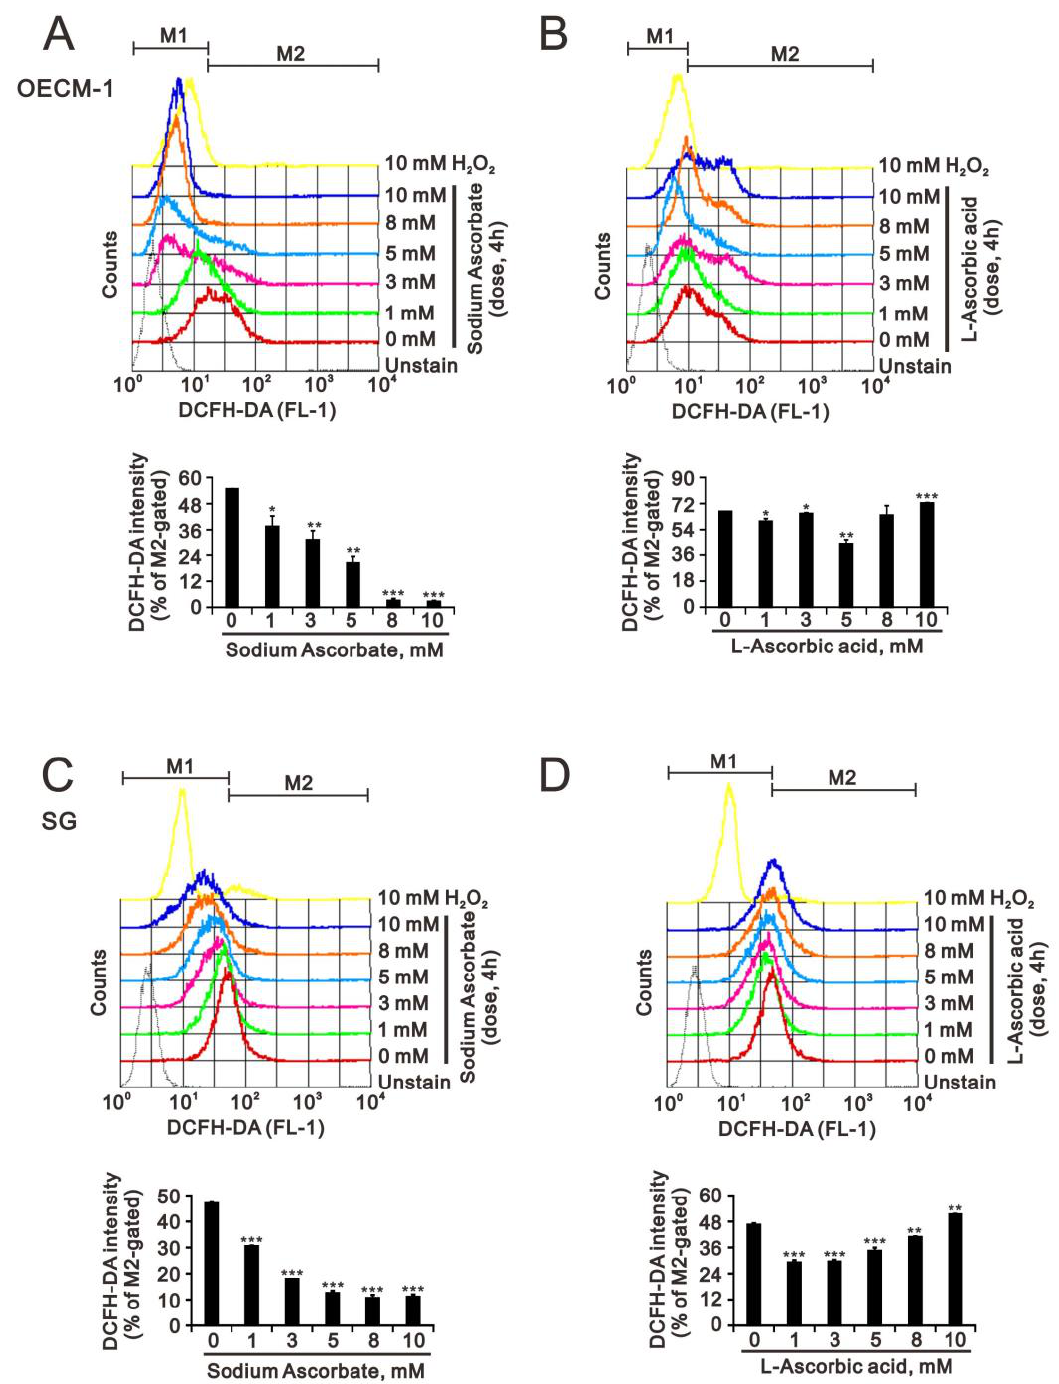
Figure 6. Effects of sodium ascorbate and L-ascorbic acid on the levels of cytosolic ROS in OECM-1 and SG cells. ( A , B ) OECM-1 (3.5 × 10 5 ) and ( C , D ) SG (3.5 × 10 5 ) cells were cultured in 6-well plates and treated with the indicated concentrations of sodium ascorbate for 4 h. They were then subjected to measurement of DCFH-DA intensity. Bars depict the mean ± SD of three independent experiments. Student’s t -tests were analyzed and compared with vehicle. * p < 0.05, ** p < 0.01 and *** p < 0.001.